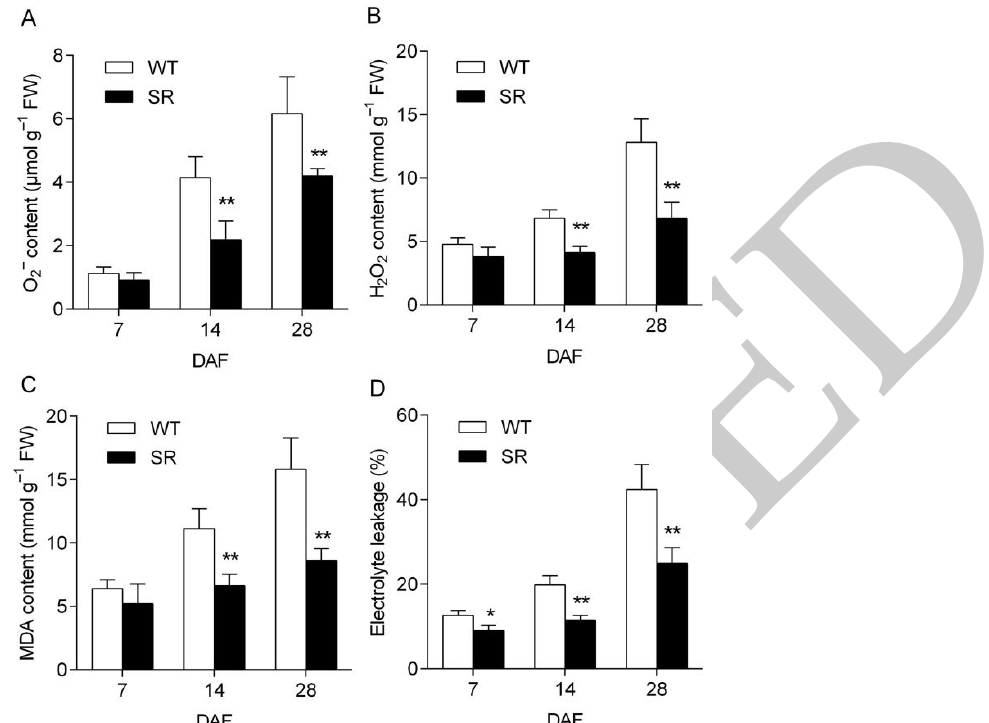
Figure 5. SR exhibits reduced ROS accumulation and oxidative damage in leaves during senescence. ( A ) O 2– content of flag leaves in WT and SR. ( B ) H 2 O 2 content of flag leaves in WT and SR. ( C ) MDA content of flag leaves in WT and SR. ( D ) Electrolyte leakage of flag leaves in WT and SR. Values ( A – D ) are given as means ± SD ( n = 3). Asterisks indicate significant differences between WT and SR. * p < 0.05; ** p < 0.01 compared with WT by Student’s t -test.